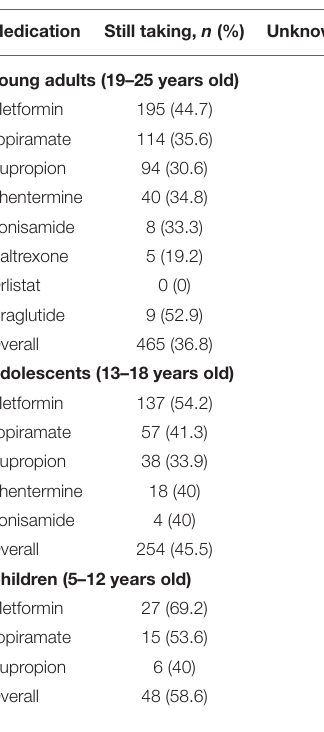
TABLE 4 | Reasons for medication discontinuation as recorded in the